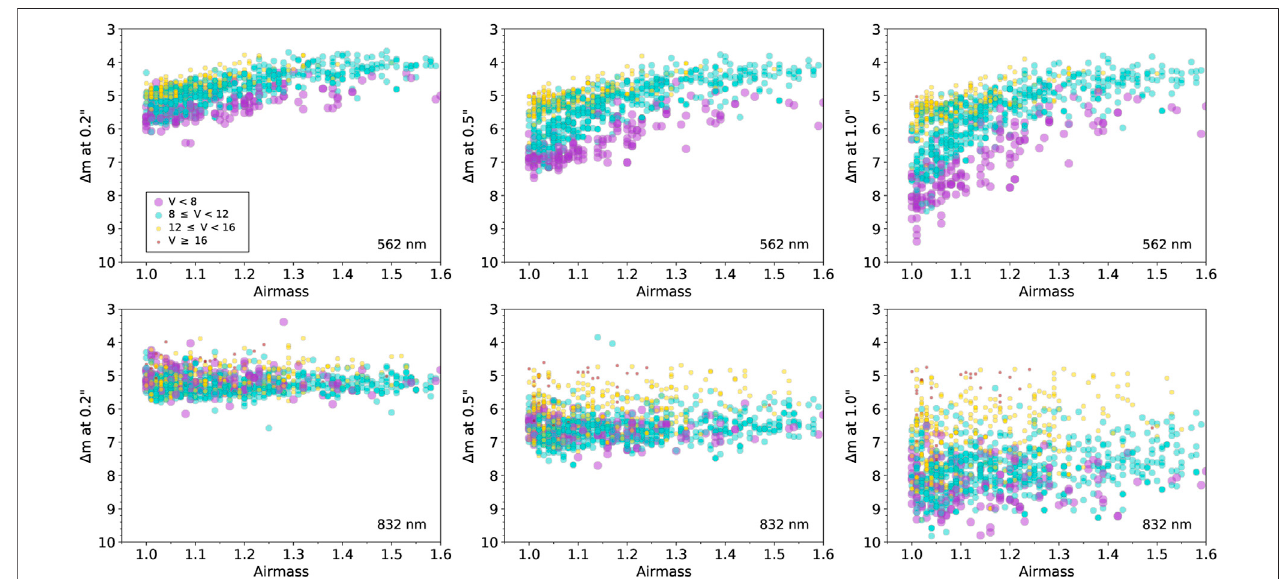
FIGURE 5 | Similar to Figure 3 , but showing the results in terms of how airmass effects the limiting contrast achieved for a given target magnitude.